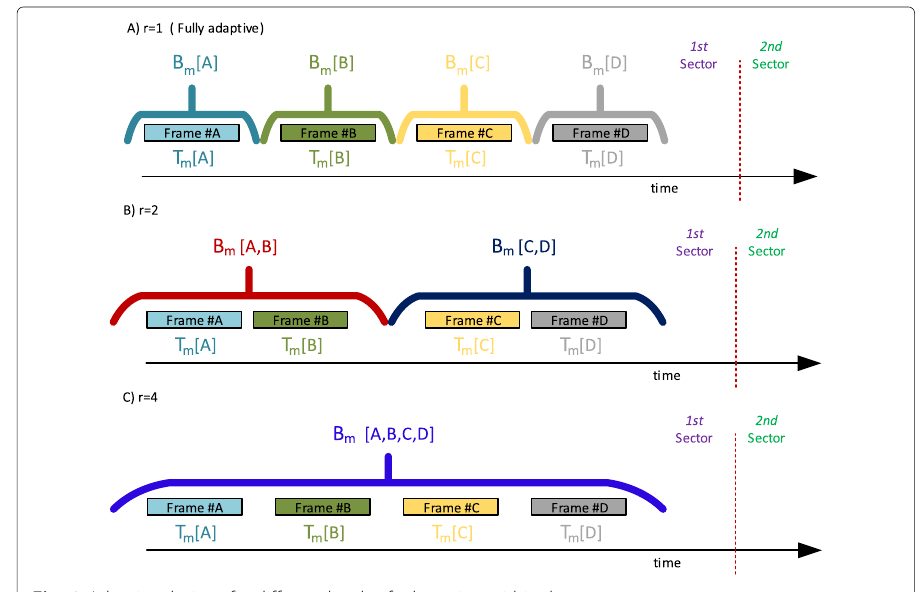
Fig. 6 Adaptive designs for different levels of adaptation within the sector